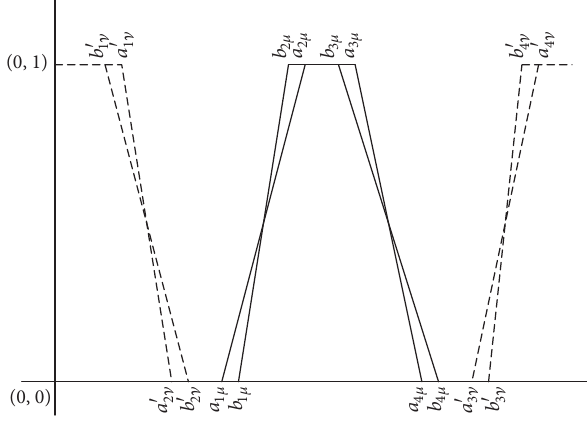
Figure 8: Pictorial representation of Example